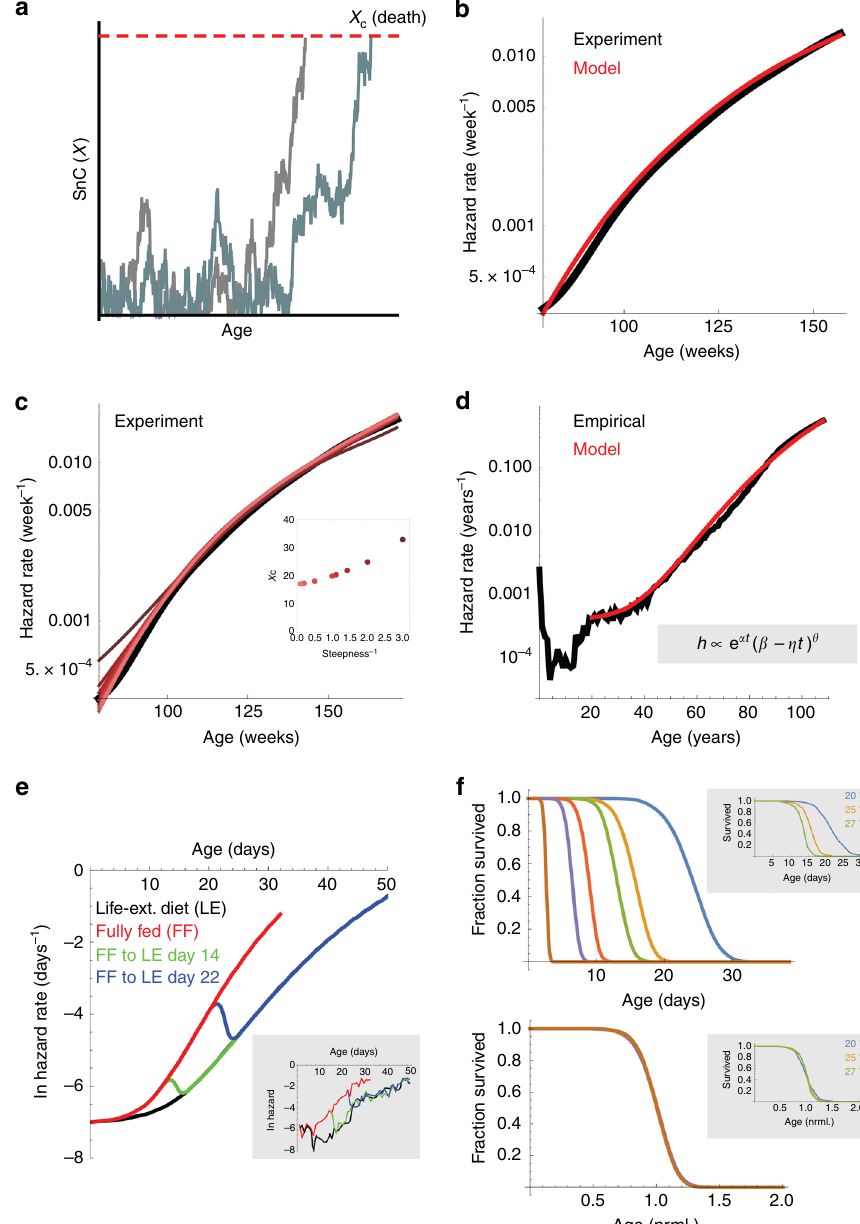
Fig. 4 SR model can explain the variability in mortality between individuals. a To model the relation between risk of death and SnC levels, we assumed a simple threshold model where death occurs when SnC abundance exceeds a critical threshold X C . b Mouse mortality (C57BL/6J mice obtained from the Mouse Phenome Database 60 , black line) is well fi t by the SR model (red line) with parameters consistent with the data of Figs. 1, 2, with death de fi ned when SnC exceed a threshold ( η = 0.084 day − 1 year − 1 , β = 0.15 day − 1 , κ = 0.5, ε = 0.16 day − 1 , X C = 17). c Similar results are obtained by assuming a more (cid:1) (cid:3) (cid:2) 1 . Parameters are the same as b , except that X general sigmoidal dependency between SnC abundance X and risk of death: h ¼ 1 þ e (cid:2) θ X (cid:2) X C ð Þ C is adjusted according to the steepness parameter θ (inset). d The SR model with added age-independent extrinsic mortality of 0.4 × 10 − 3 year − 1 (red) matches human mortality statistics 61 (black). Inset: approximate analytical solution for the fi rst passage time in the SR model shows the Gompertz law and deceleration at old ages. The parameters are similar to b , except a ~60-fold decrease in η : η = 0.00135 day − 1 year − 1 , β = 0.15 day − 1 , κ = 0.5, ε = 0.142 day − 1 , X C = 17. e SR model describes rapid shifts in mortality when fully fed Drosophila transition to a lifespan-extending dietary intervention (LE), (inset: experimental data from Mair et al. 45 ), with β = 1 h − 1 , κ = 1, ε = 1 h − 1 , η = 0.03 day -1 h − 1 and X C = 15. LE was modeled by a decrease in η : η = 0.02 h − 1 day − 1 (changes in other parameters lead to similar conclusions, see Supplementary Note 8). f Lifespan of C. elegans raised at different temperatures varies by an order of magnitude, but survival curves collapse on a single curve when time is scaled by mean lifespan (inset: data from Stroustrup et al. 35 ). The SR model provides scaling for perturbations that affect η , but not other parameters ( β = 1 h − 1 , κ = 1, and ε = 1 h − 1 , η = 0.07 h − 1 day − 1 , X C = 20, Supplementary Note 9). Source data are provided as a Source Data fi